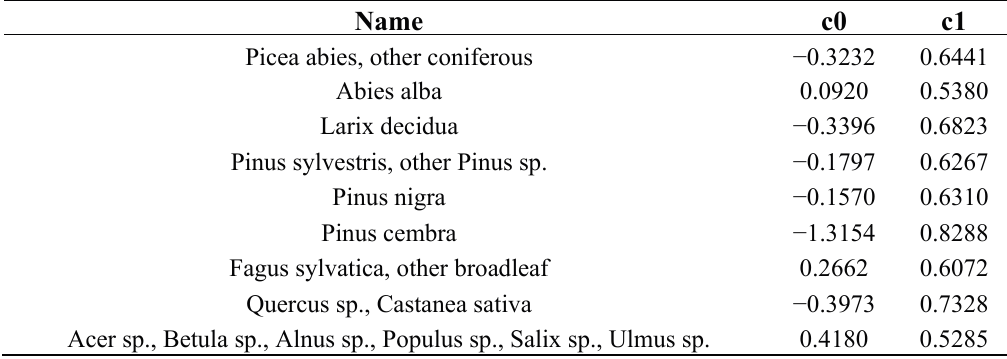
Table A6 . Coefficients used for maximum crown width